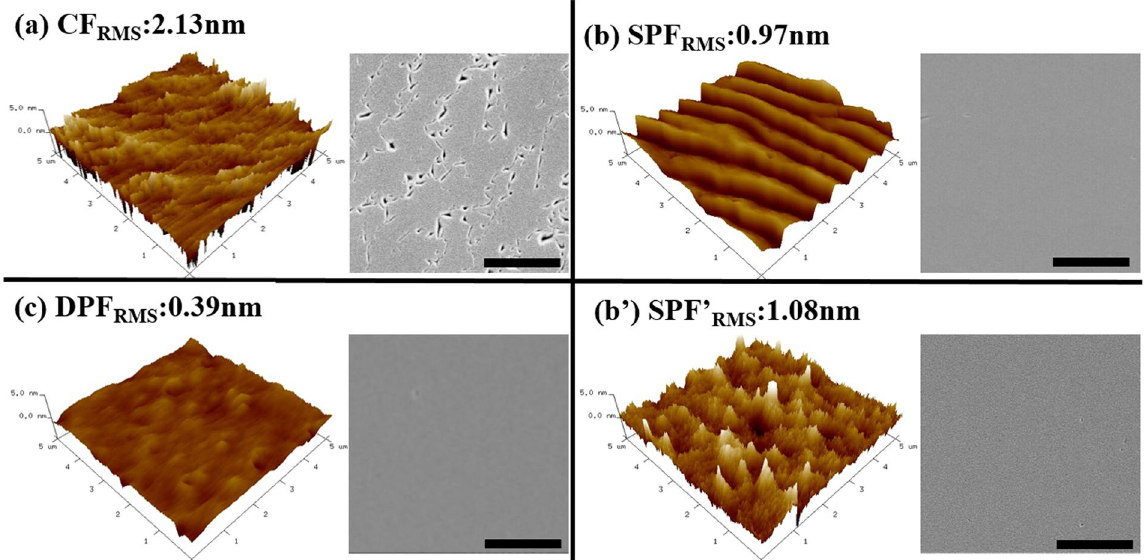
Figure 2. AFM (5 × 5 μ m 2 ) images (on the left) with corresponding RMS roughness and SEM images (on the right) recorded on the ( a ) CF sample; ( b ) SPF sample; ( b’ ) SPF sample with the growth stopped at the red dash line indicated in Fig. 1(b); ( c ) DPF sample. Scale bars in the SEM images are 1 μ m. It can be seen that the surface smoothness is effectively improved by the PF condition.